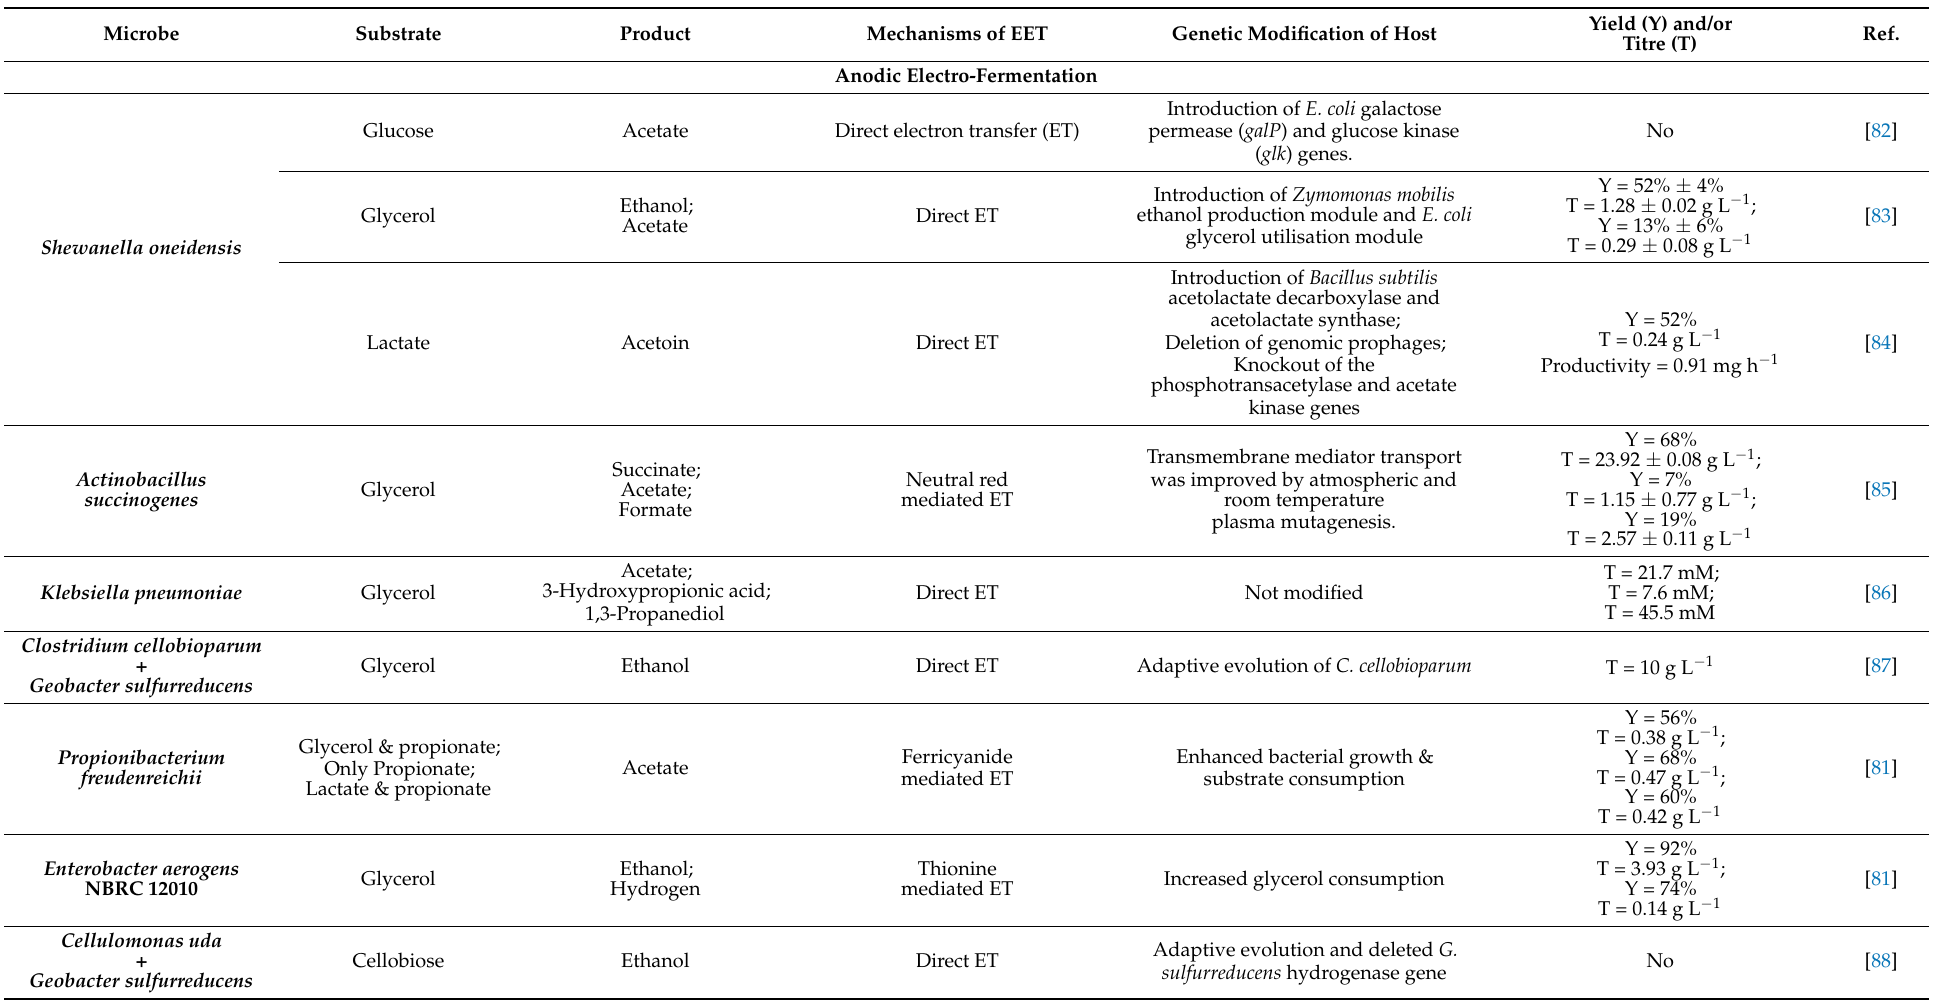
Table 1. Synthesis of high-value chemicals through anodic electro-fermentation and microbial electrosynthesis (MES). Adapted from